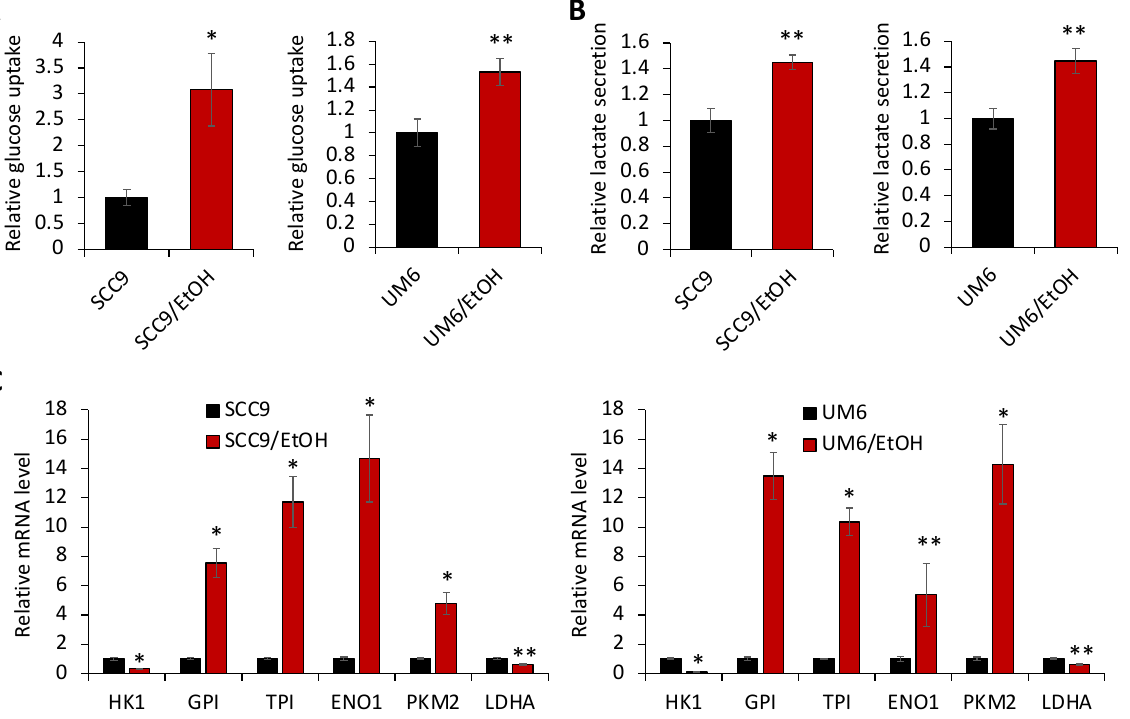
Figure 3. Chronic EtOH exposure increases the glycolytic activity of OSCC. ( A ) Effect of chronic EtOH exposure on glucose uptake by OSCC was determined using a Glucose-Glo™ assay kit (Promega). Relative glucose uptake by the EtOH-exposed cells (SCC9/EtOH and UM6/EtOH) were plotted